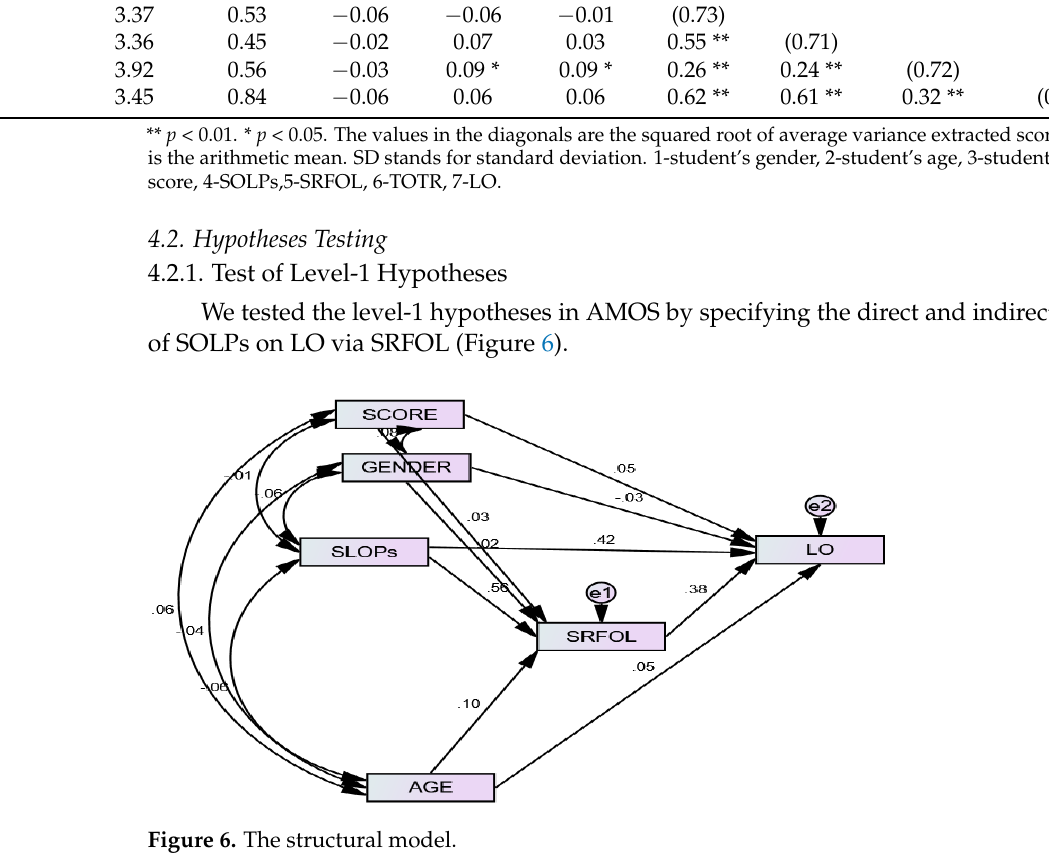
Figure 6. The structural model.